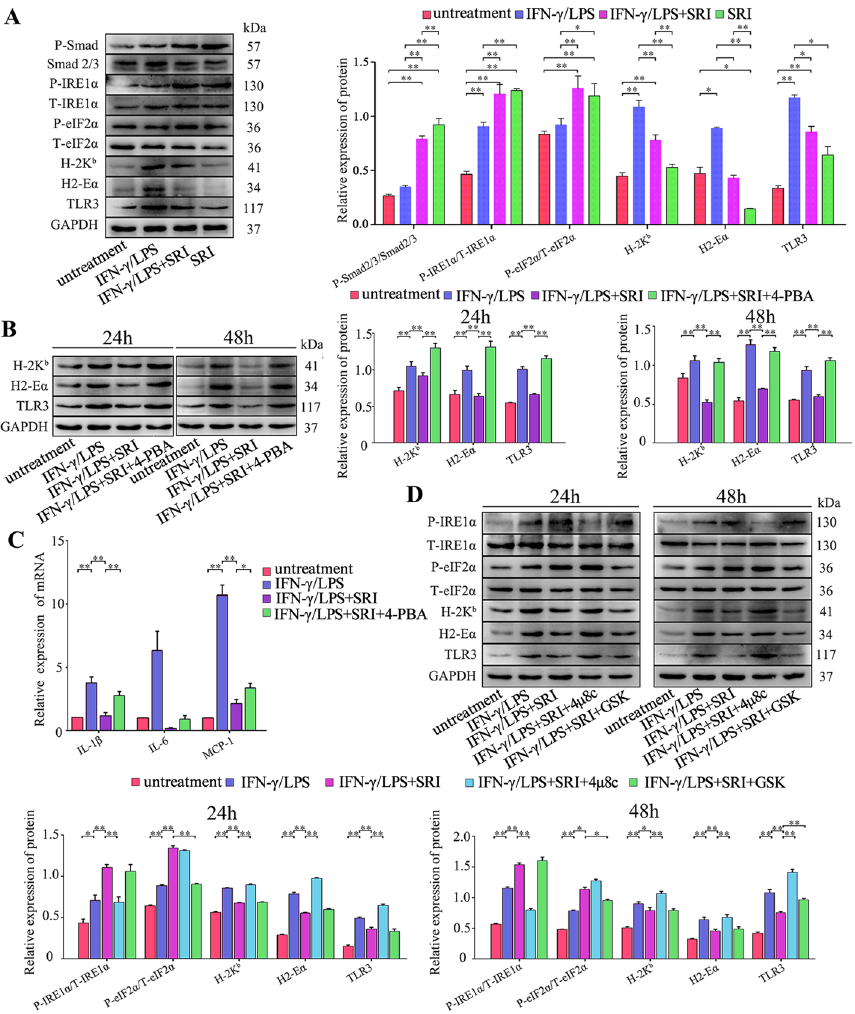
Fig. 8 TGF-β signaling inhibits immunological characteristics of myofibers through activating the IRE1α pathway. Western blot analyses of the expression changes of Smad pathway proteins, IRE1α and PERK pathway proteins, and immunological molecules in MPC-myotubes isolated from SM TGF-βr2 − / − mice, with or without 48 h stimulation of IFN-γ/LPS and/or SRI ( A ); 24 or 48 h stimulation of IFN-γ/LPS, SRI, 4-PBA, 4μ8C (IRE1α pathway inhibitor) or GSK (PERK pathway inhibitor) ( B , D ). The relative protein expression values are expressed as a ratio [protein of interest/GAPDH or phosphorylated (P) protein/total (T) protein]. C mRNA levels of IL-1β, IL-6, and MCP-1 in MPC-myotubes isolated from SM TGF-βr2 − / − mice, with or without 48 h stimulation of IFN-γ/LPS, SRI and/or 4-PBA,analyzed by qPCR. All data are presented as means one-way ANOVA was used for multiple comparisons (* P < 0.05; ** P <